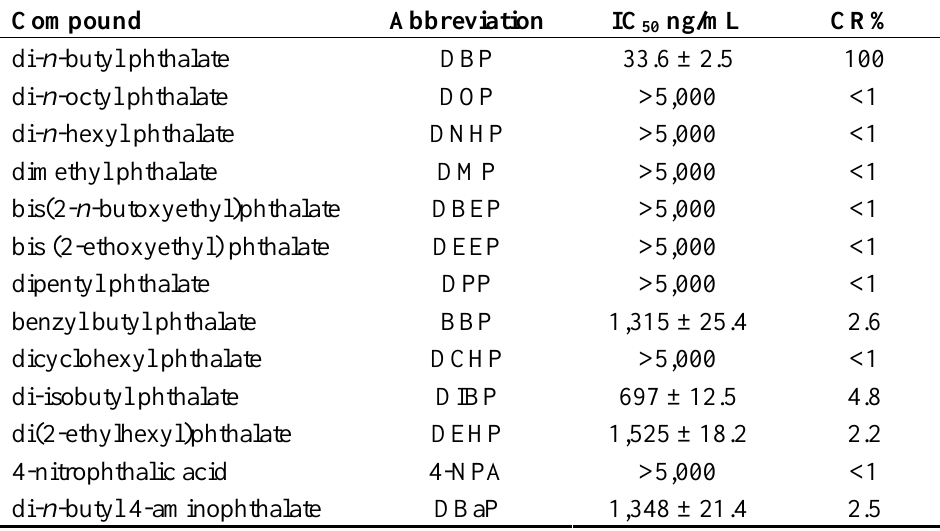
Table 1. Cross reactivity results under the optimized ELISA